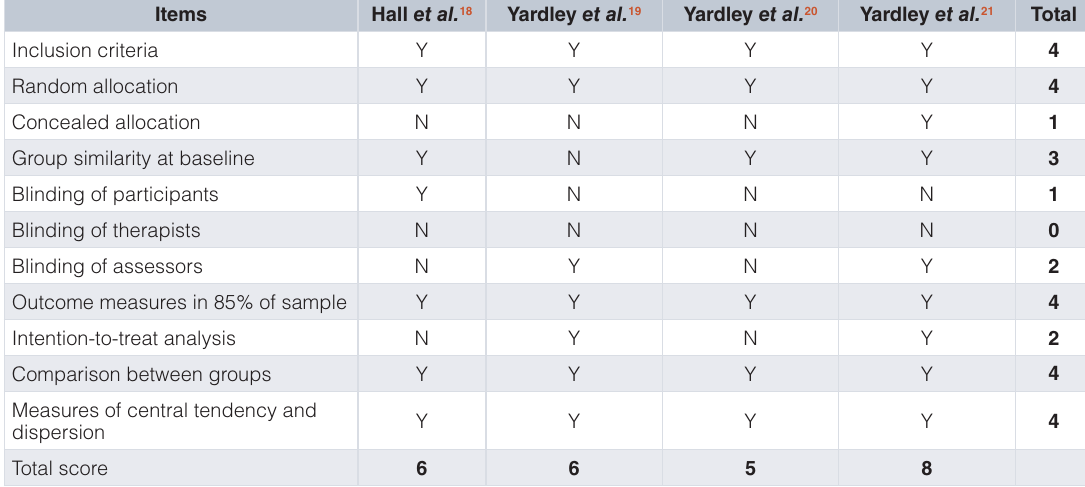
Table 3. Quality appraisal of included studies.